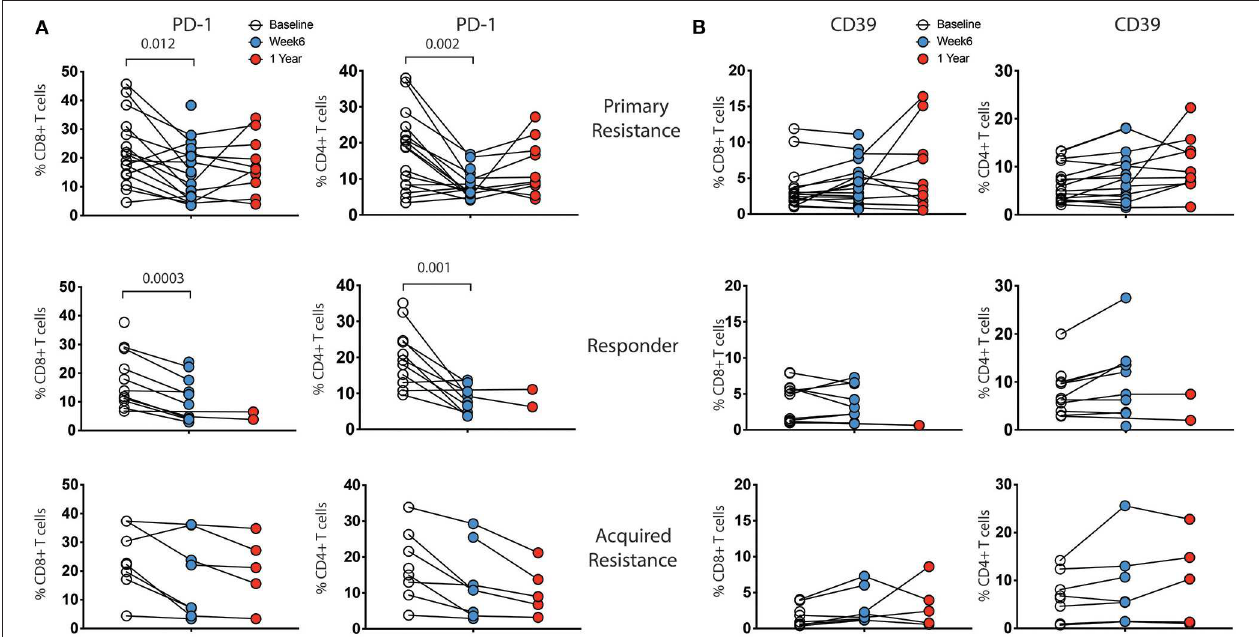
FIGURE 4 | Expression levels of inhibitory receptors on CD4 and CD8T cells by treatment outcome. PBMCs were analyzed for expression of CD39, PD-1, TIGIT, TIM-3, and KLRG1 on CD4 and CD8T cells. There were no significant differences in expression between the groups at any timepoint. Expression of (A) PD-1 and (B) CD39 showed changes within individual subjects over the course of therapy, while TIM-3, TIGIT, and KLRG1 did not (not shown). Baseline, open circles; week 6, blue filled circles; 1 year, red filled circles. Differences in frequencies of immune cell populations between the 3 timepoints were assessed using a repeated measures mixed effects analysis followed by Tukey’s multiple comparisons test and p -values are